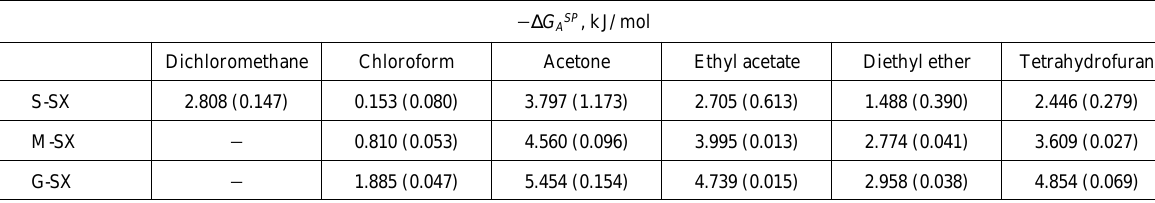
Table IV The specific component of surface free energies of adsorption, (cid:5) ∆ G ASP